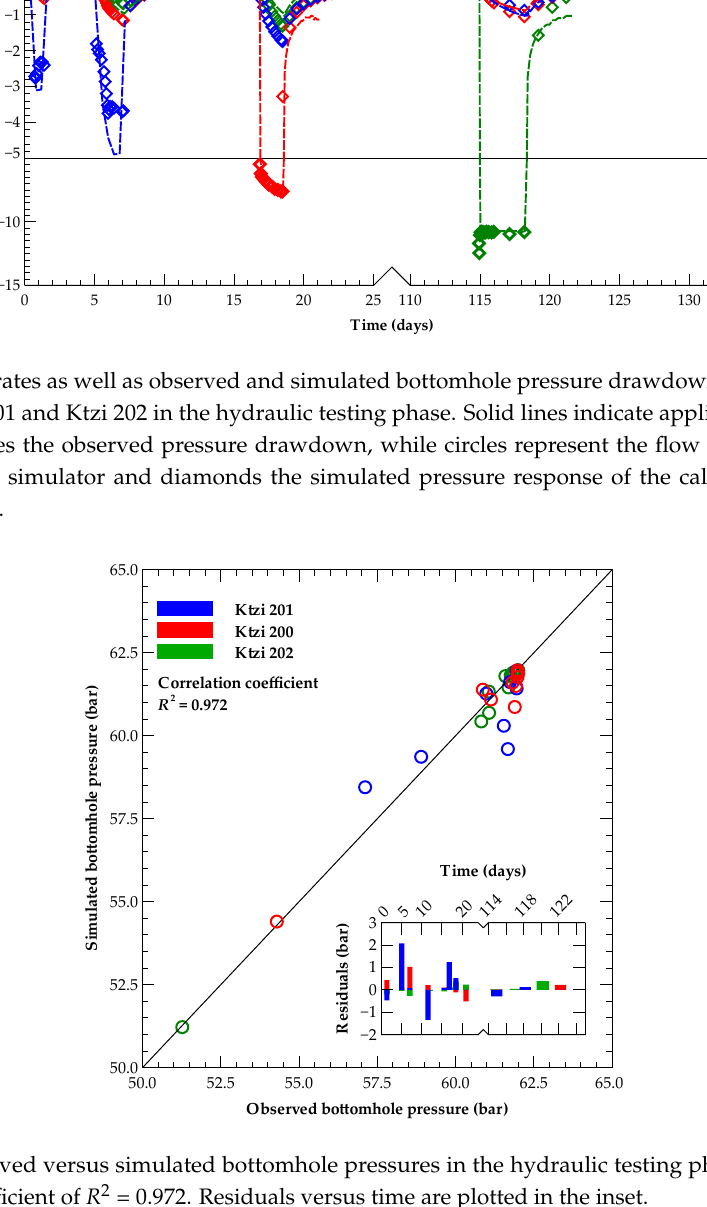
Figure 3. Observed versus simulated bottomhole pressures in the hydraulic testing phase exhibit a correlation coefficient of R 2 = 0.972. Residuals versus time are plotted in the